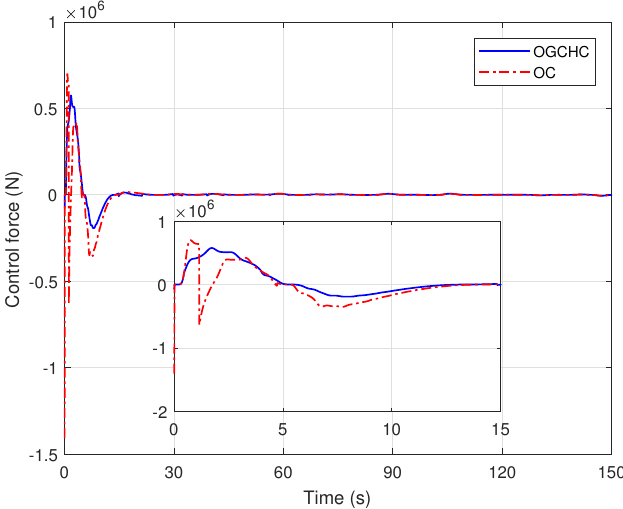
Figure 10. Control force with OC and OGCHC under case